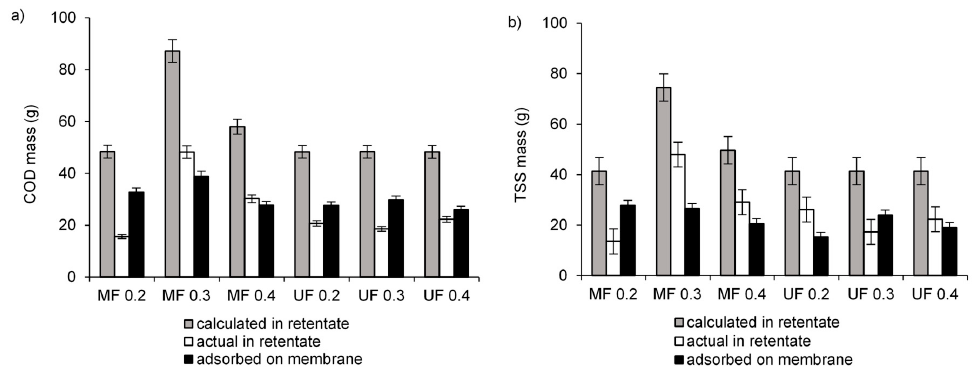
Figure 3. Calculated and actual mass of concentrations of organic compounds (COD) ( a ) and TSS ( b ) in retentates from MF and UF and mass adsorbed on the membranes.